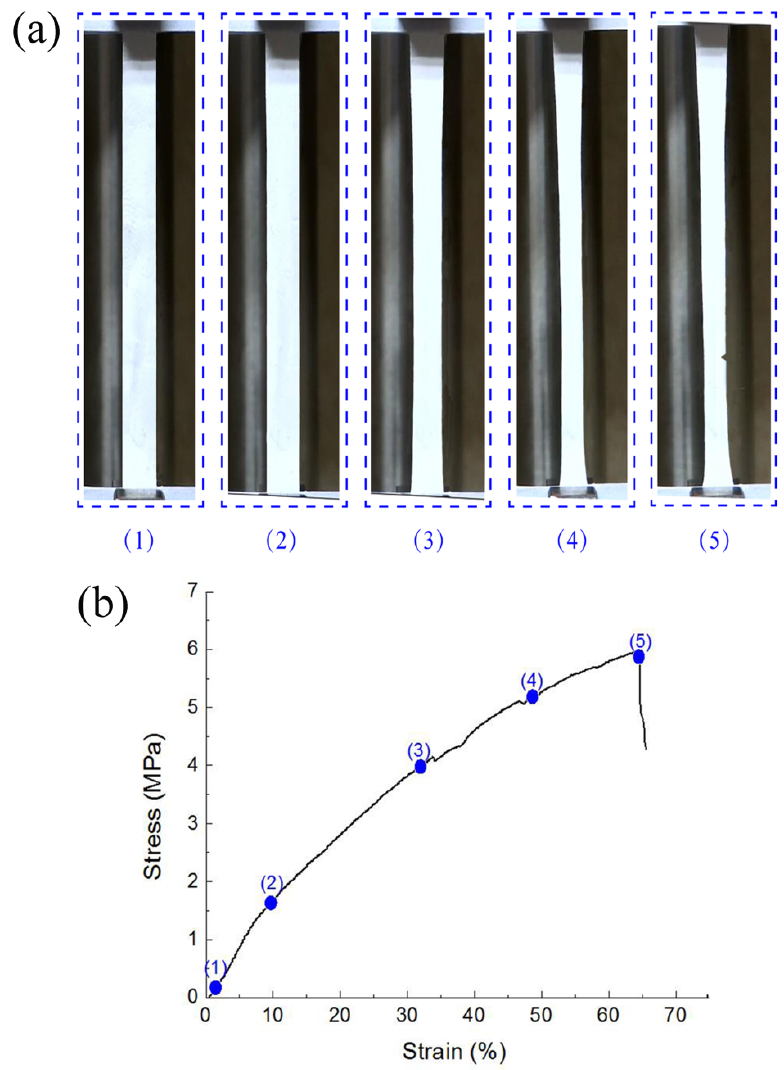
Figure 7. Figure 7. Typical deformation characteristics of nanofibrous membrane with the progress of stress– stress–strainresponseunderuniaxialtensiletesting: ( a )morphologychangesofnanofibrousmembranes, strain response under uniaxial tensile testing: ( a ) morphology changes of nanofibrous membranes, ( b ) ( b ) stress–strain curves of nanofibrous stress–strain curves of nanofibrous membranes.